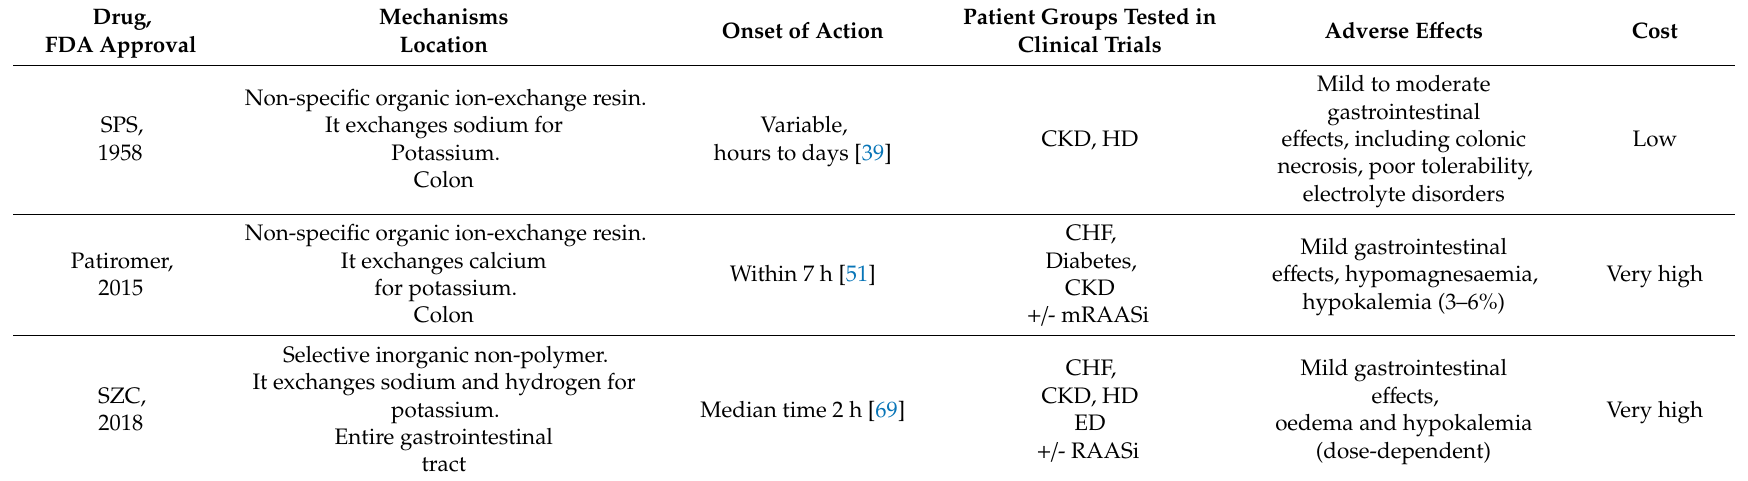
Table 3. Main characteristics of the approved potassium binders for the treatment of